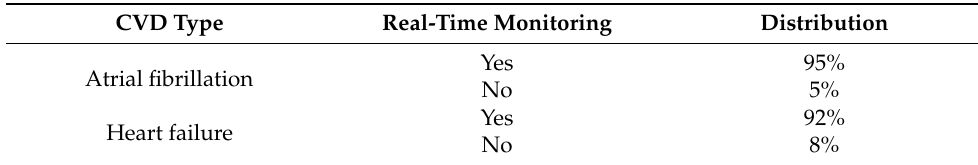
Table 4. Noncommercial wearables with real-time monitoring capabilities.